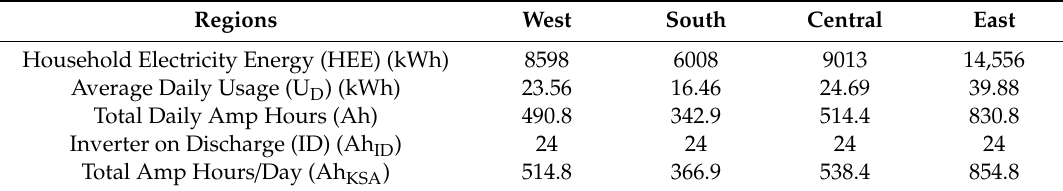
Table 8. The electrical usage for 48 V solar plant in the Kingdom of Saudi Arabia (KSA) for di ff erent regions.